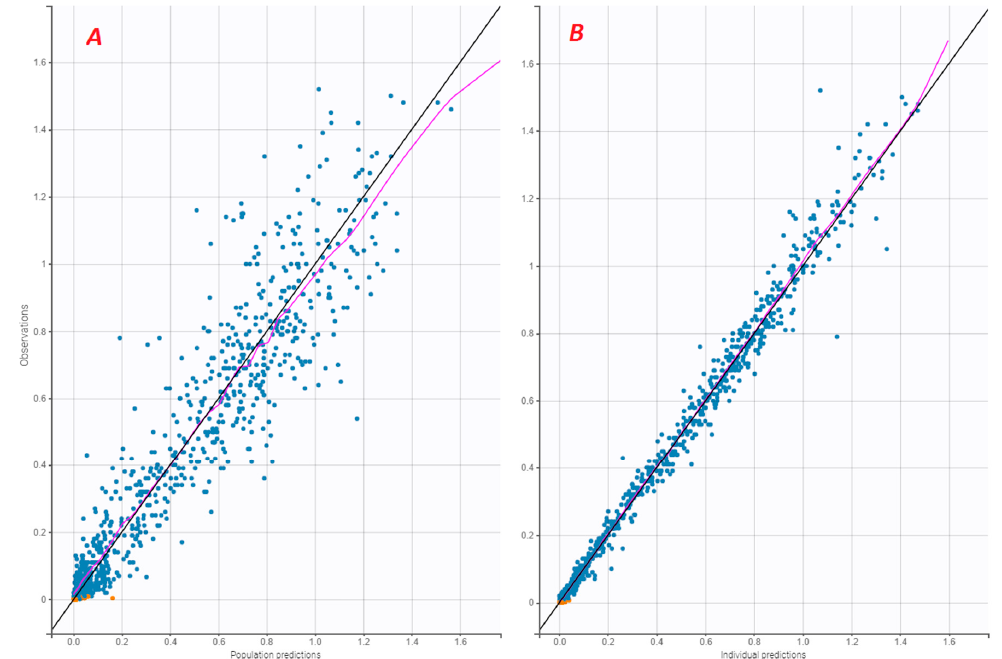
Figure 1. ( A ) Observed FVIII:C (IU / mL) versus population predictions (IU / mL); ( B ) Observed FVIII:C (IU / mL) versus individual predictions (IU / mL). Blue dots are observed FVIII:C; orange dots are observed Figure 1. (A ) Observed FVIII:C (IU/mL) versus population predictions (IU/mL); (B ) Observed FVIII:C Pharmaceutics 2020 , 12 , x 8 of 15 FVIII:C BLQ; the purple solid line is the spline. (IU/mL) versus individual predictions (IU/mL). Blue dots are observed FVIII:C; orange dots are observed FVIII:C BLQ; the purple solid line is the spline.